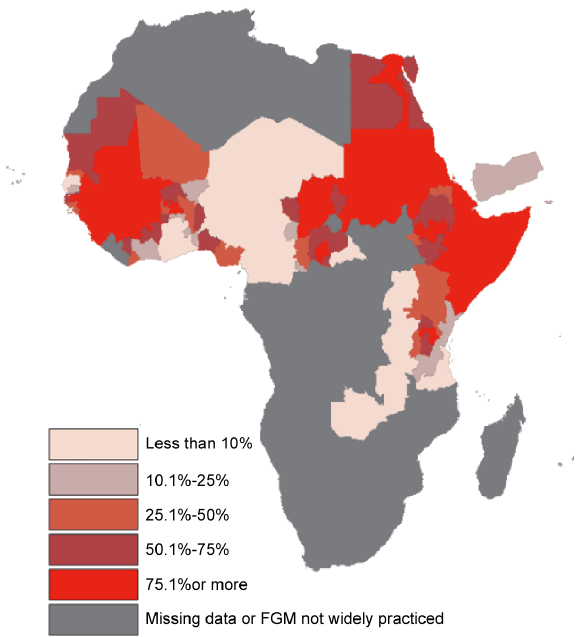
Figure 2. Depicting the prevalence of female genital mutilation among women aged 15-49 in Africa and